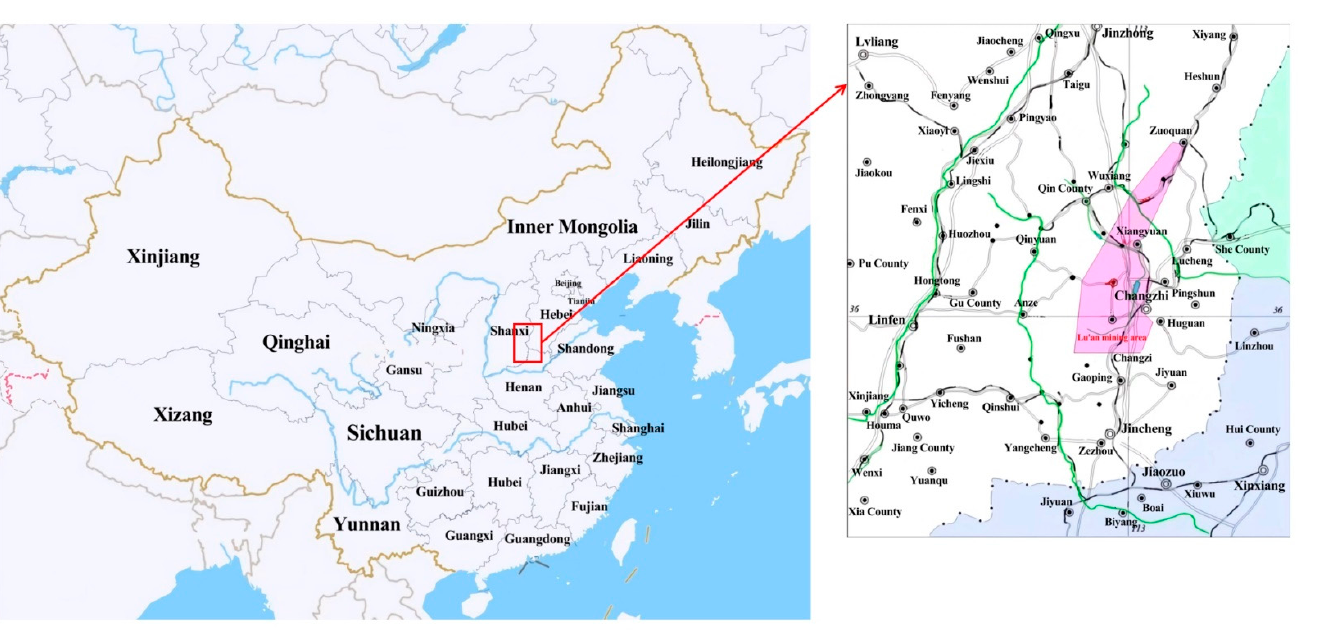
Figure 6. Location Map of Lu’an Mining